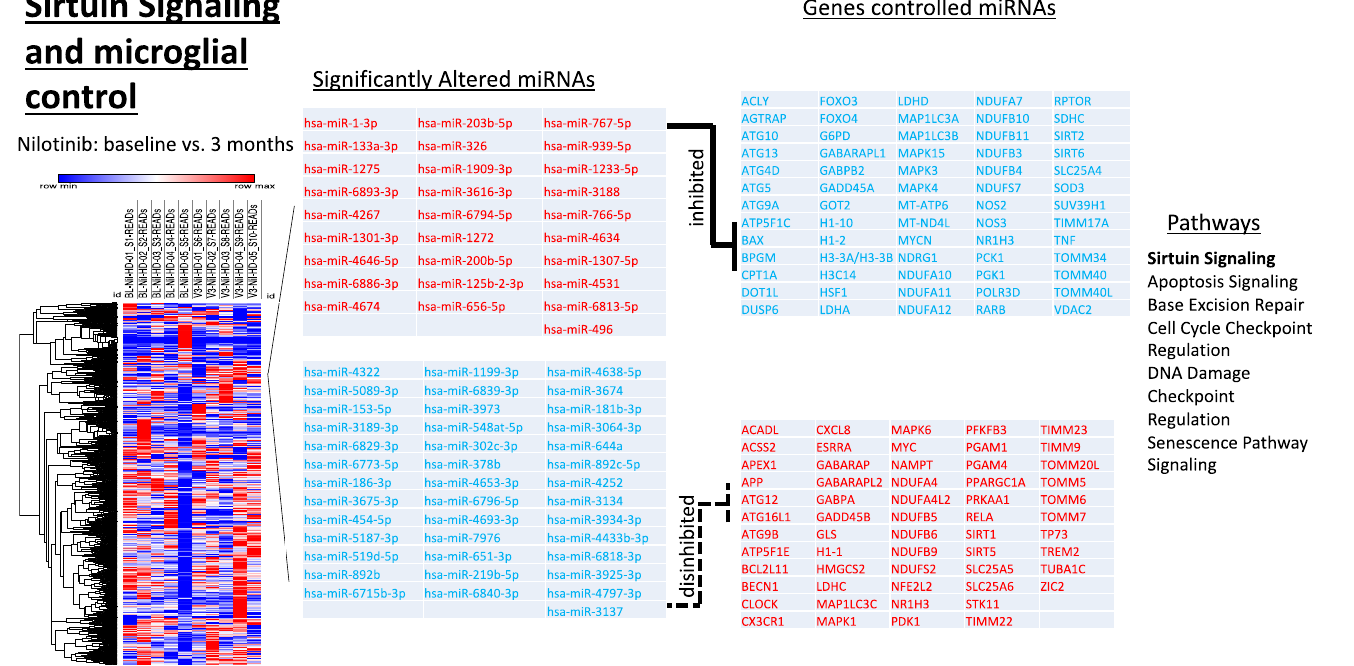
Figure 5. miRNAs targeting genes associated with sirtuin signaling and microglial control. Gene ontology analysis revealed 28 upregulated and 40 downregulated miRNAs that target 123 genes experimentally observed to be associated with sirtuin signaling and senescence.